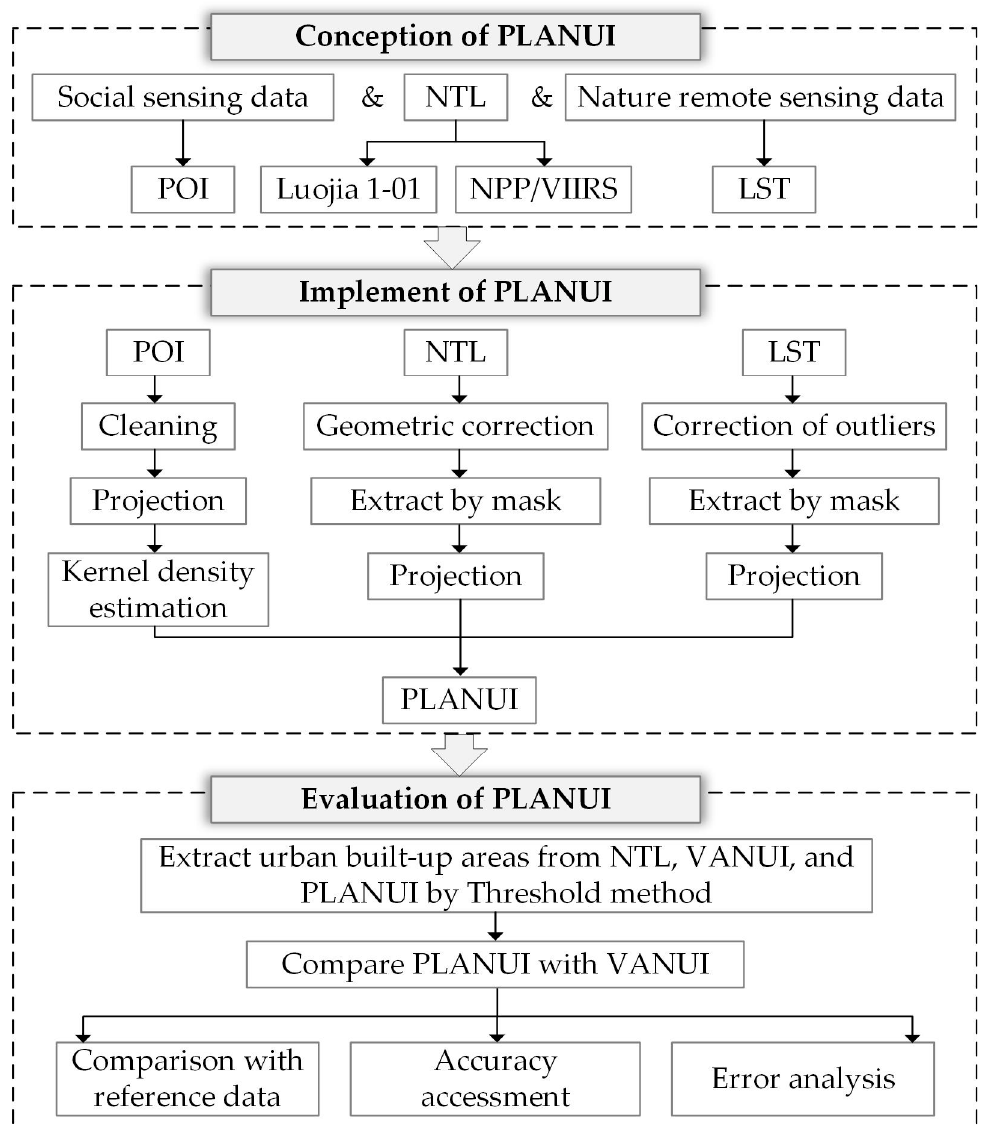
Figure 4. The workflow of conception, implement and evaluation of PLANUI for urban built-up area extraction.